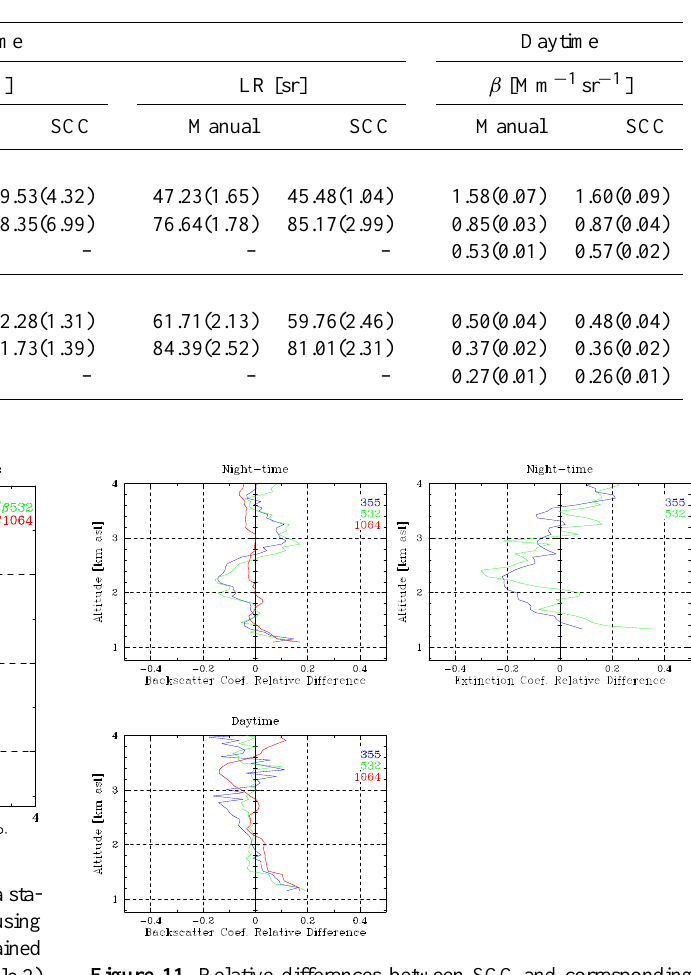
Figure 11. Relative differences between SCC and corresponding manually retrieved mean profiles for the Potenza station (MUSA system). On the left (upper part) the deviation between night-time mean aerosol backscatter profiles at 355, 532, and 1064nm (see Fig. 9) are shown. On the right (upper part) the deviations between night-time mean aerosol extinction profiles at 355 and 532nm (see Fig. 9) are reported. In the bottom part the deviation between day- time mean aerosol backscatter profiles at 355, 532, and 1064nm (see Fig. 10) are